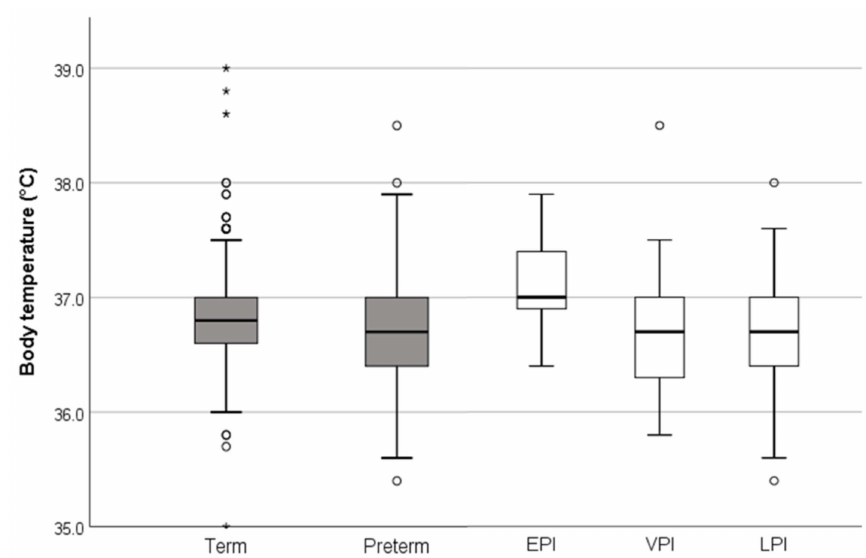
Figure 3. Boxplot (box: median, 1st and 3rd quartile; whisker: lower and upper extreme within 1.5 times the inter-quartile range from the upper or lower quartile; O: outliner > 1.5 to < 3 times the interquartile range from the upper or lower quartile, *: extreme outliner ≥ 3 times the interquartile range from the upper or lower quartile; highest and lowest extreme outliner demonstrate minimum and maximum range) of body temperature ( ◦ C) according to gestational age: term ( ≥ 37 + 0 weeks of gestation), preterm ( < 37 + 0 weeks of gestation) and subgroups EPI (extremely preterm infants ≤ 28 + 0 weeks of gestation), VPI (very preterm infants > 28 + 0 and < 32 + 0 weeks of gestation), and LPI (late preterm infants ≥ 32 + 0 and < 37 + 0 weeks of gestation). Table 3. Prevalence of normothermia (36.5–37.5 ◦ C), mild hypothermia (36.0–36.4 ◦ C),